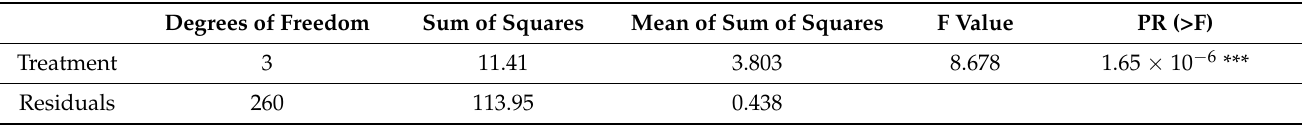
Table A7. Summary of ANOVA